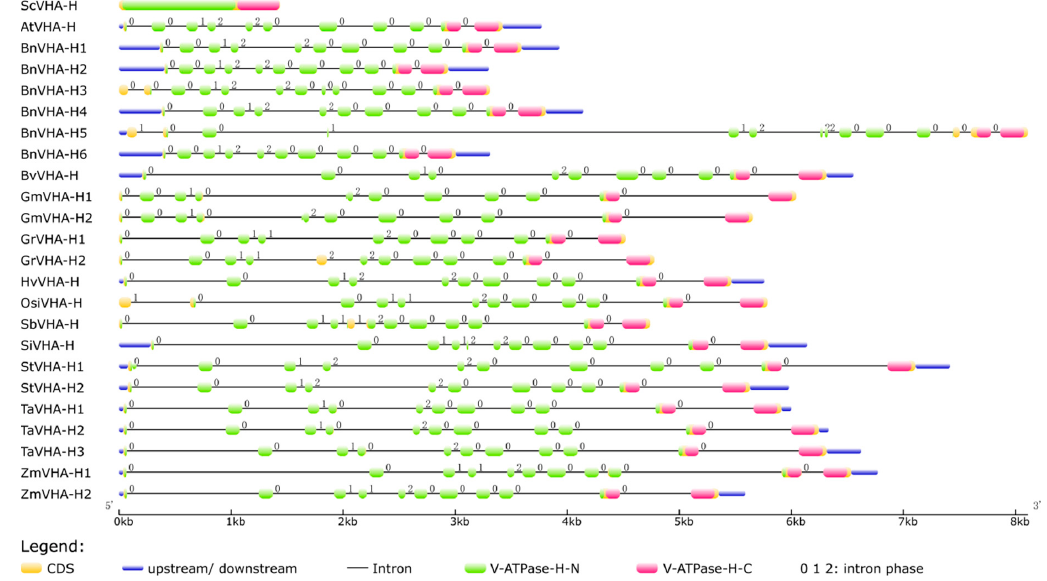
Figure 3. Exon-intron structures of the 24 VHA-H genes in 12 species of plants and yeast. Exons and introns are illustrated with filled boxes and single black lines, respectively. Conserved protein sequences of V-ATPase-H N-terminal and C-terminal domains are marked in green and pink, respectively, while the rest of the CDS is highlighted in yellow. Untranslated regions (UTRs) are displayed using blue rectangles at both ends of the sequences. Intron phases 0, 1, and 2 are shown on the top left of the black lines. The ruler at the bottom indicates the lengths of the genes in kb.